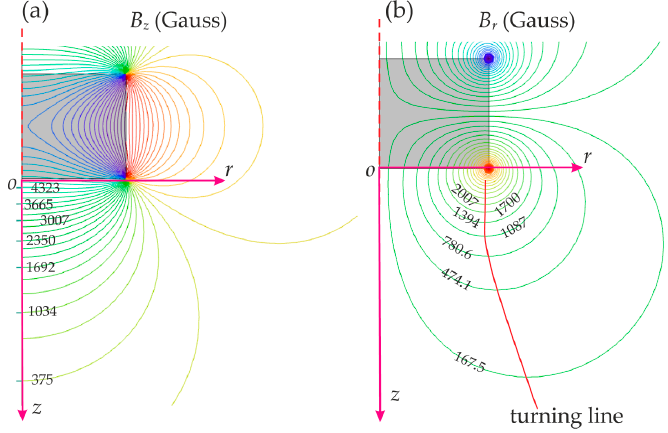
Figure 3. Magnetic field of a cylinder magnet in the z - r plane ( H m = 0.5 R m ): ( a ) B z contour; ( b ) B r contour.